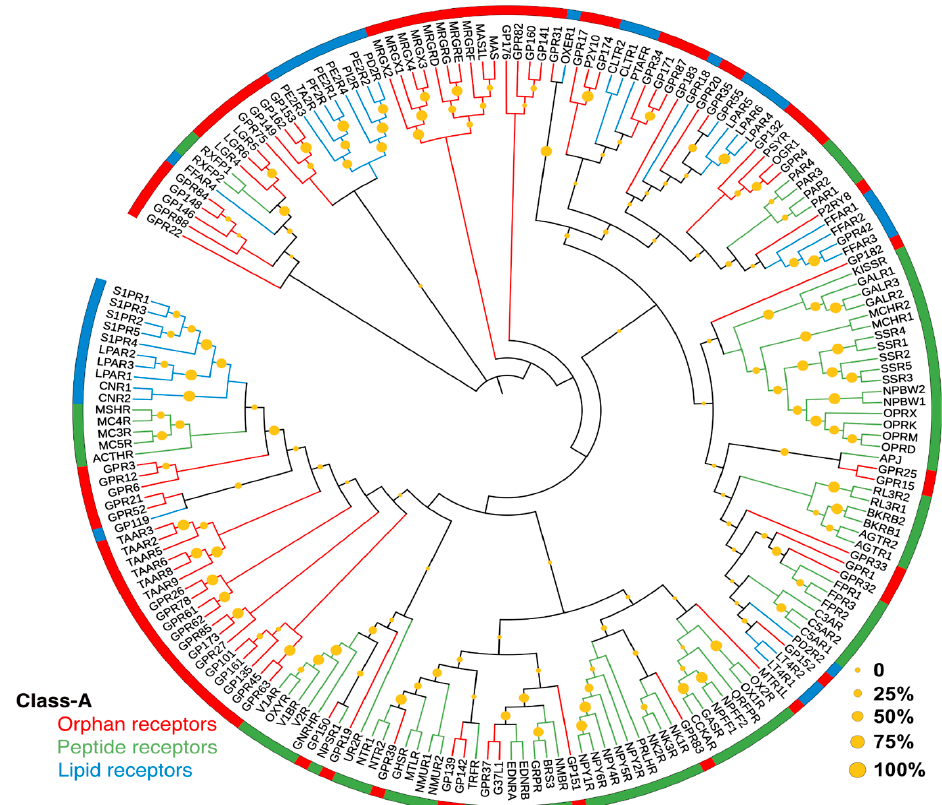
Figure 2. Phylogenetic tree of 193 Class-A lipid, peptide, and orphan receptors. The alignment of the sequence of the transmembrane region was downloaded from the GPCRdb [17] database and the phylogenetic tree was constructed using the maximum likelihood tree method using 1000 replicates in MEGAX software suite [20]. The circular graphical representations of phylogenetic trees were displayed in a circular tree layout using iTOL version 5 [21]. The lipid, peptide, and orphan receptors are shown in blue, green, and red colors, respectively. Bootstrap confidence values for the nodes are given by yellow spheres.